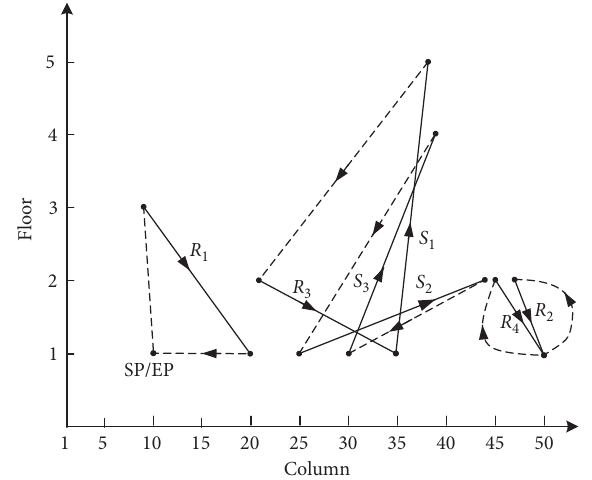
Figure 14: An example of minimum cost merging with four subloops: the horizontal axis and the vertical axis represent the column and floor, where the stacker access point is located, re- spectively, the solid line represents load travel, and the dotted line represents no-load travel.